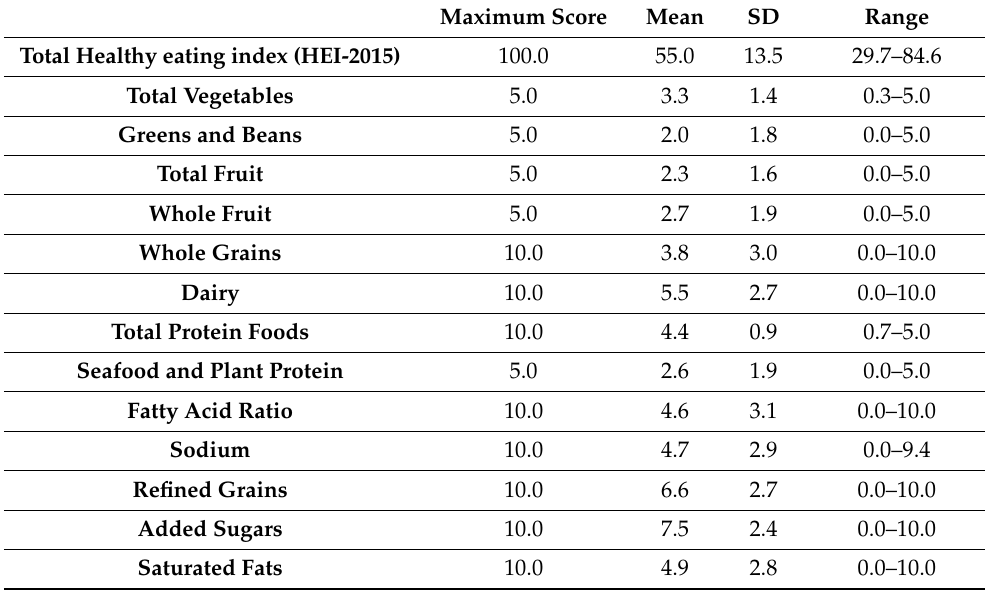
Table 1. Mean HEI-2015 total and component scores among women’s cancer survivors (n = 52).